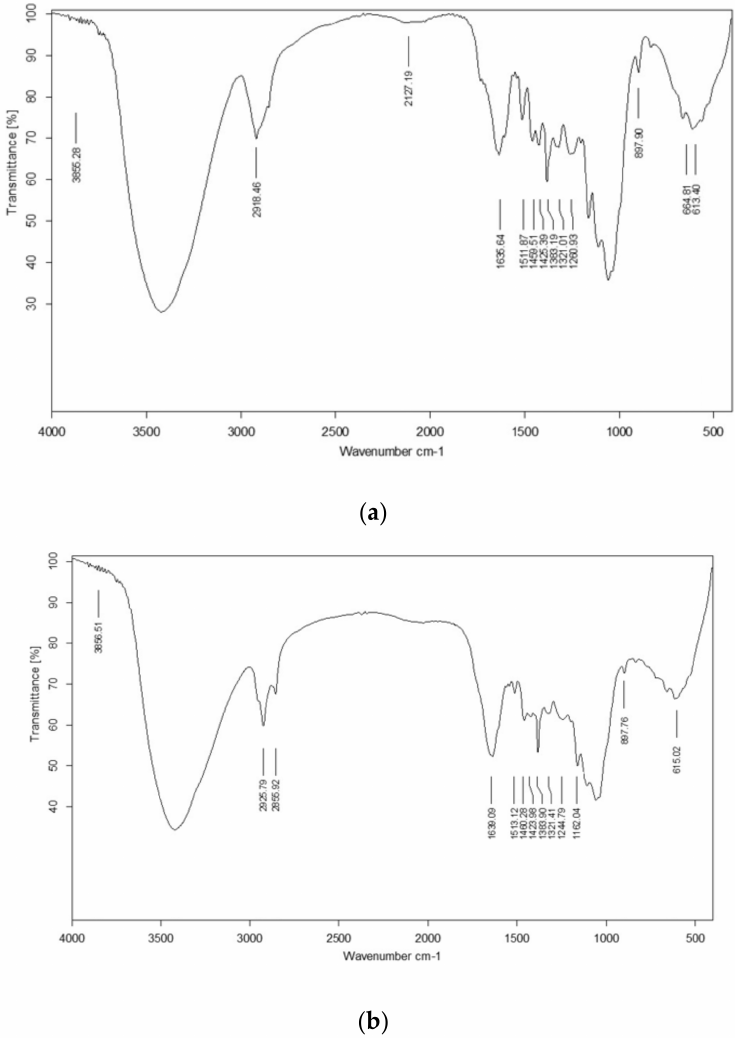
Figure 2. FTIR spectra of ( a ) pretreated sugarcane bagasse and ( b ) fermented sugarcane